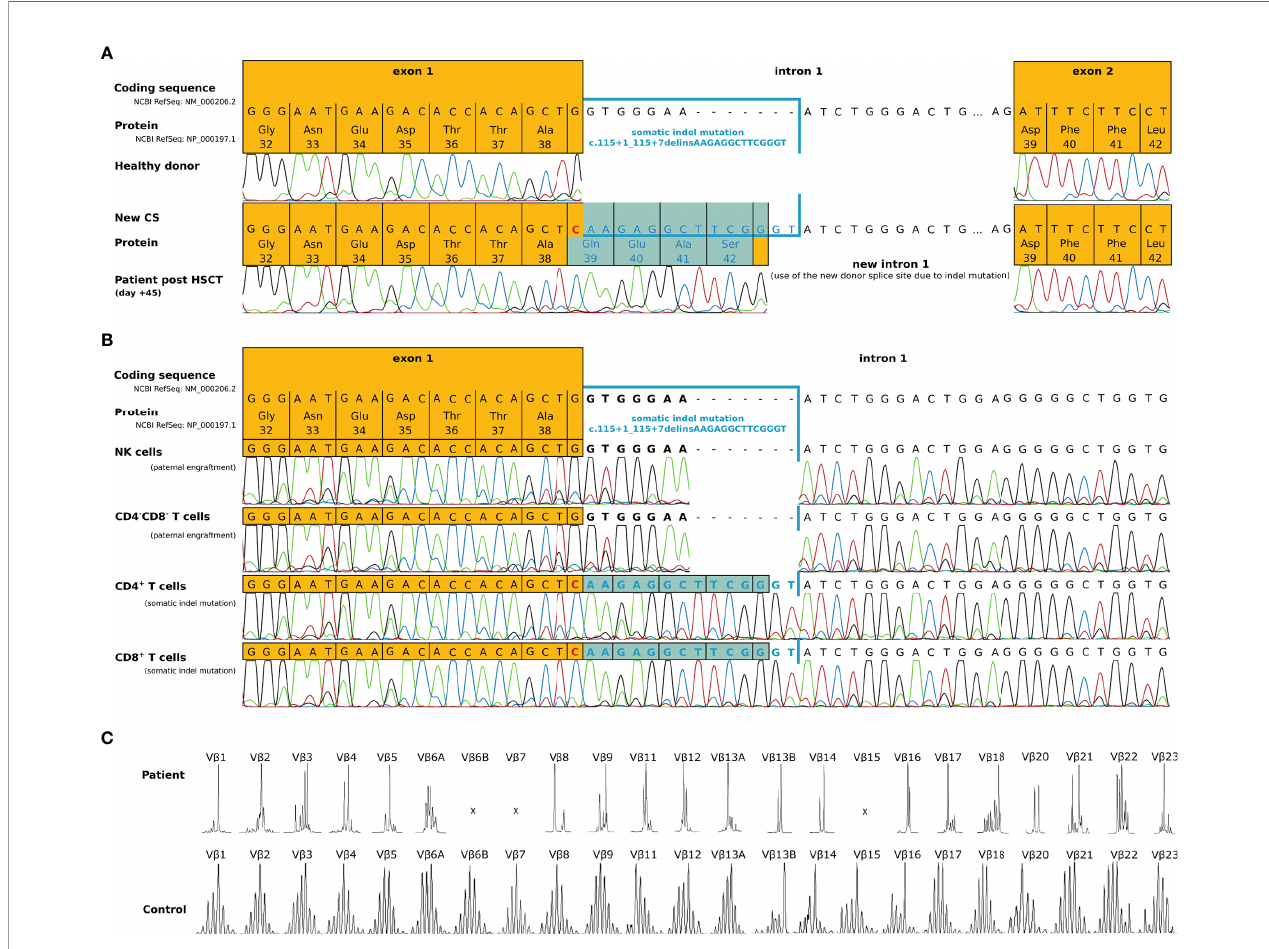
FIGURE 2 | Molecular characterization of a second-site IL2RG mutation 45 days post-HSCT. (A) IL2RG mutation analysis of cDNA derived from EBV transfected lymphoblastoid cell lines of the patient (day +45 post-HSCT). Due to a somatic indel mutation in intron 1 (c.115+1_115+7delinsAAGAGGCTTCGGGT), a new cryptic donor splice site within the inserted sequence was created. The transcript showed an insertion of 12 nucleotides, which lead to an inframe insertion of 4 residues (highlighted in blue), restoring the original reading frame. (B) Sequencing of genomic DNA from sorted cell populations (NK cells, CD4 - CD8 - double negative T cells, CD4 + and CD8 + T cells) of the patient (day +45 post HSCT). Paternal engraftment with wild type IL2RG was found within NK cells and CD4 - CD8 - double negative T cells. CD4+ and CD8+ T cells carried the somatic indel mutation c.115+1_115+7delinsAAGAGGCTTCGGGT that restored the reading frame (highlighted